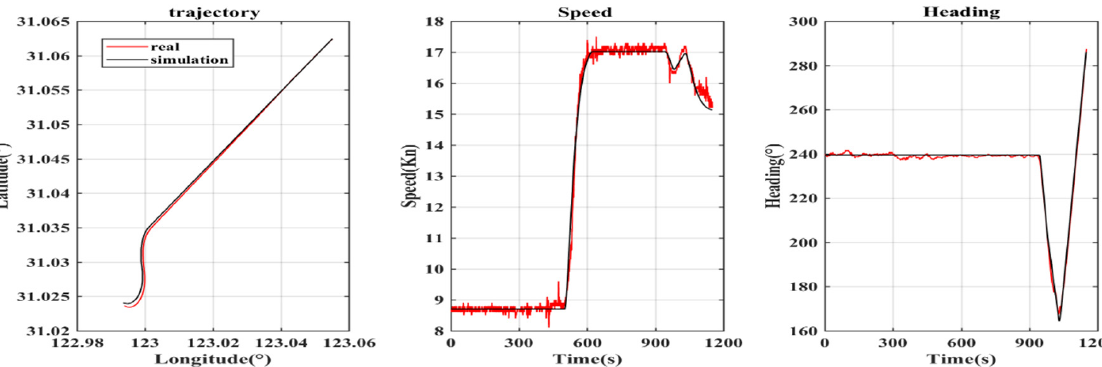
Figure 4. Comparison between measured data and the new trajectory generator.